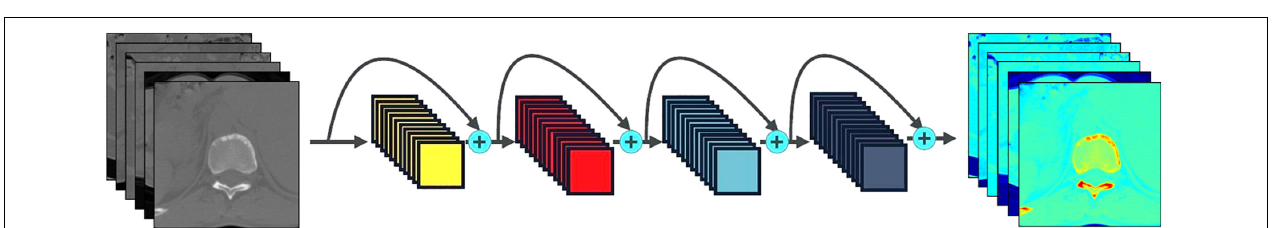
FIGURE 2 | Process of extracting the deep learning features of tuberculosis images. The series of images on the left are the raw CT data, the series of images on the right are the feature maps of the convolution layer of the CNN, and the middle represents the common